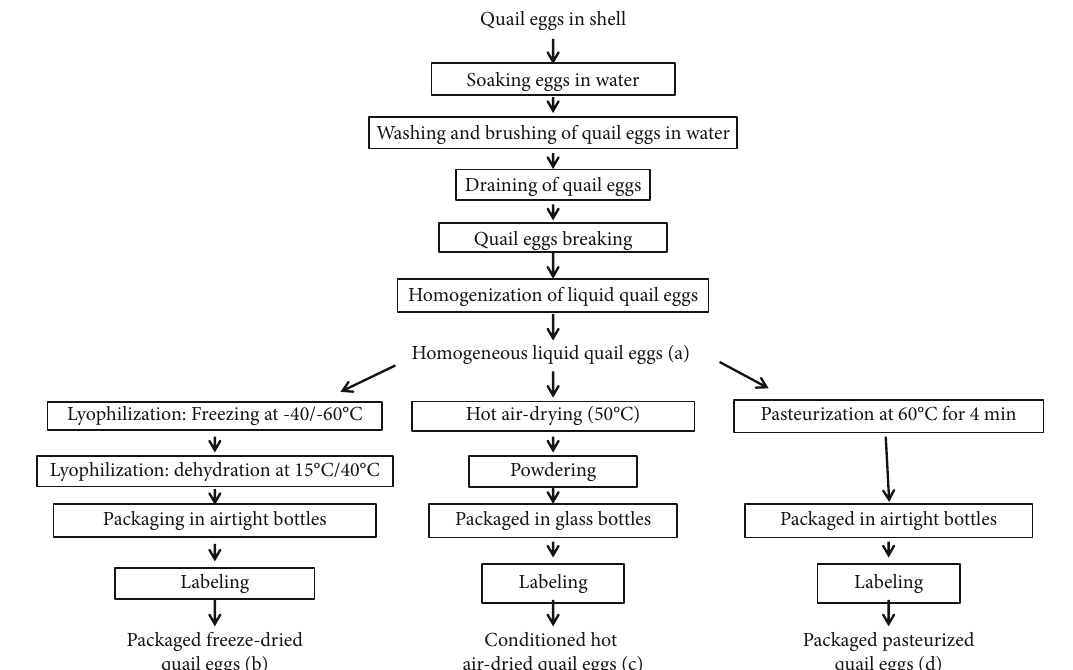
Figure 1: Production diagram of liquid (a), freeze-dried (b), hot air-dried (c), and pasteurized (d) quail